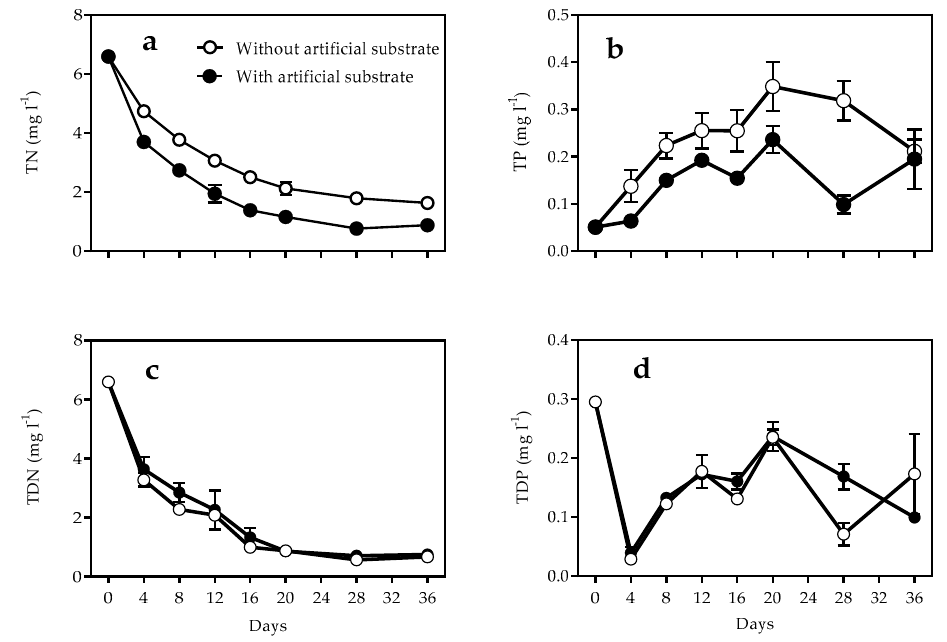
Figure 2. Comparisons of concentrations of ( a ) total nitrogen (TN); ( b ) total phosphorus (TP); ( c ) total dissolved nitrogen (TDN); and ( d ) total dissolved phosphorus (TDP) between treatments with and without artificial substrate during the experiment.